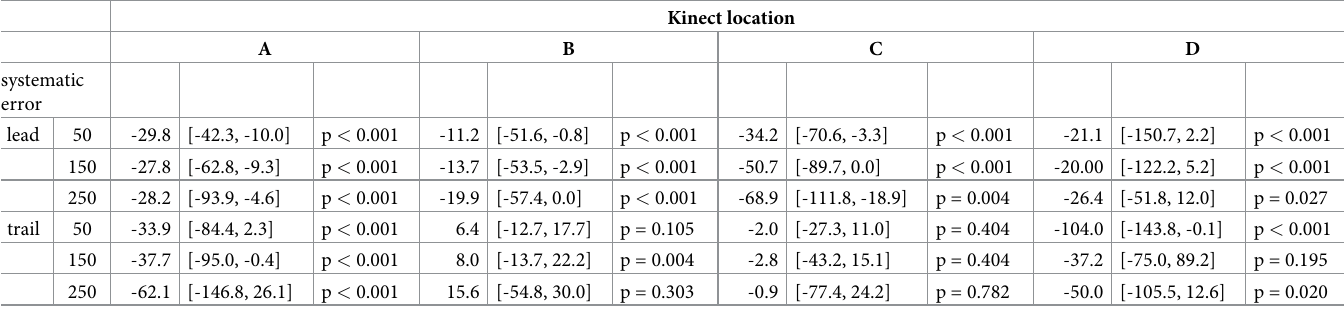
Table 2. Results of one-sample Wilcoxon signed-rank tests for the systematic